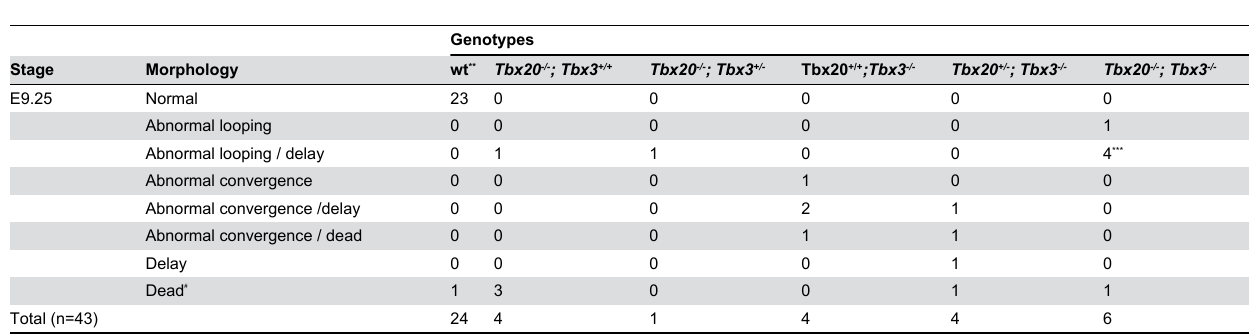
Table 3. Frequency of different morphological defects in embryos at E9.25 from matings of Tbx20 +/- ; Tbx3 +/- double heterozygotes *